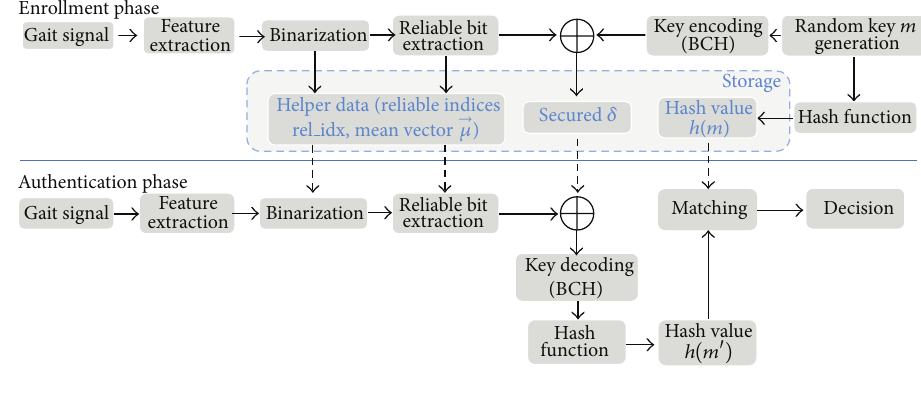
Figure 1: The overall architecture of our proposed gait based BCS using a fuzzy commitment scheme where ⊕ denotes the exclusive-OR operator.